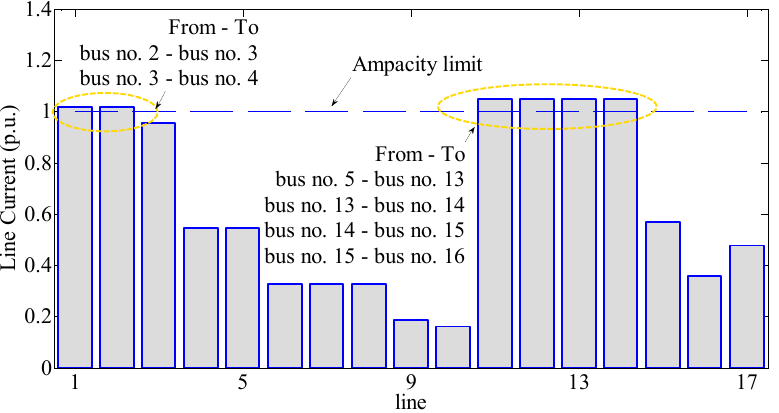
Figure 5. Case Study 1: Line currents of the residential feeder (phase no.1) at hour 21.00 of the typical day.